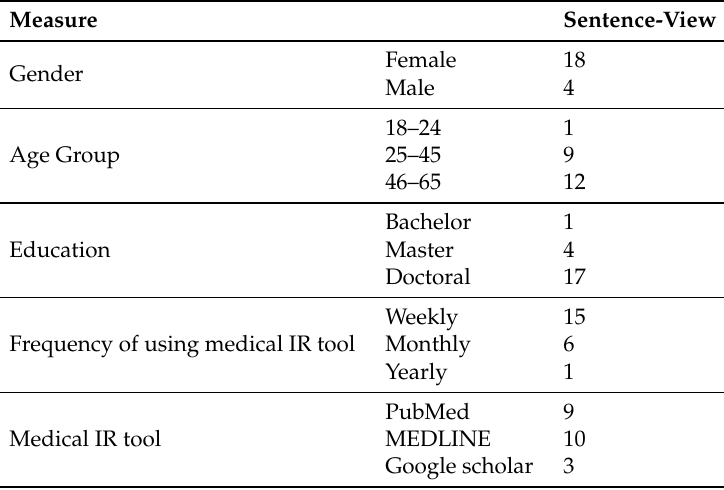
Table 2. Results of the relevance assessment